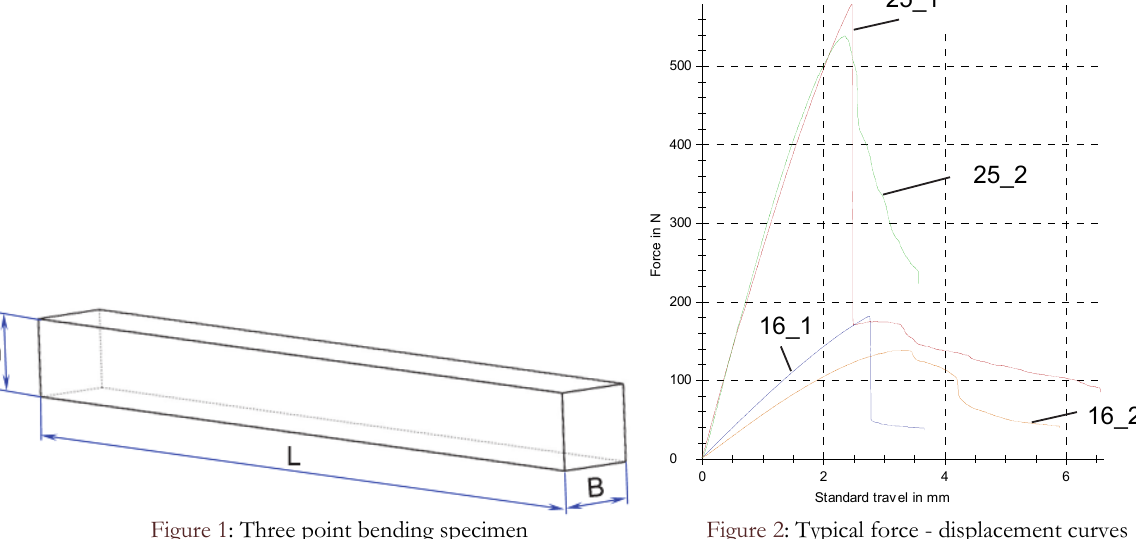
Figure 1: Three point bending specimen Figure 2: Typical force - displacement curves